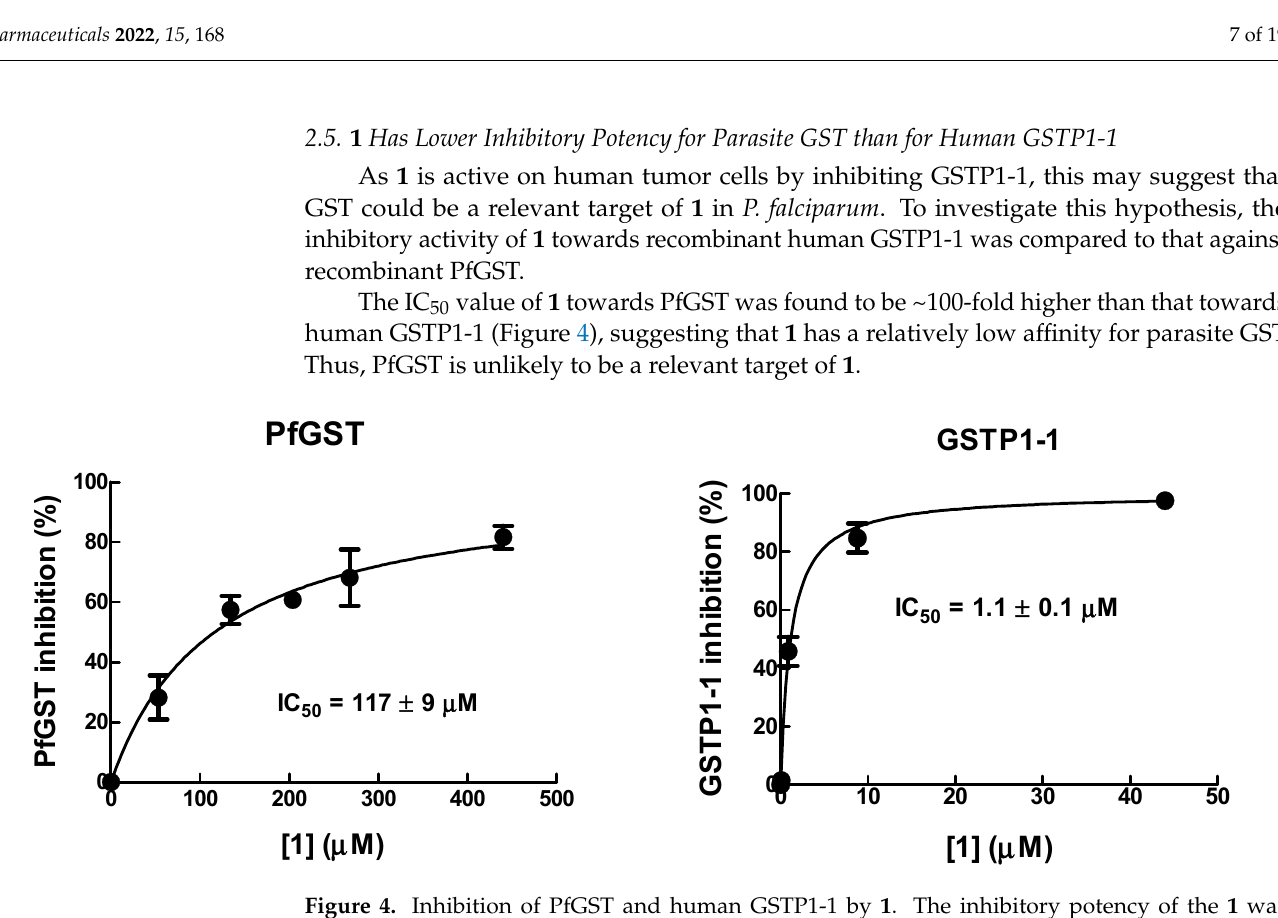
Figure 4. Inhibition of PfGST and human GSTP1-1 by 1 . The inhibitory potency of the 1 was determined by recording the activity of GST in the presence of increasing concentrations of 1 . IC 50 values were determined as described in Materials and Methods.